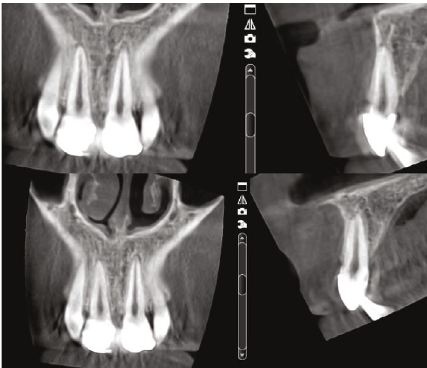
Figure 8: CBCT 5 years after trauma with a normal appearance.